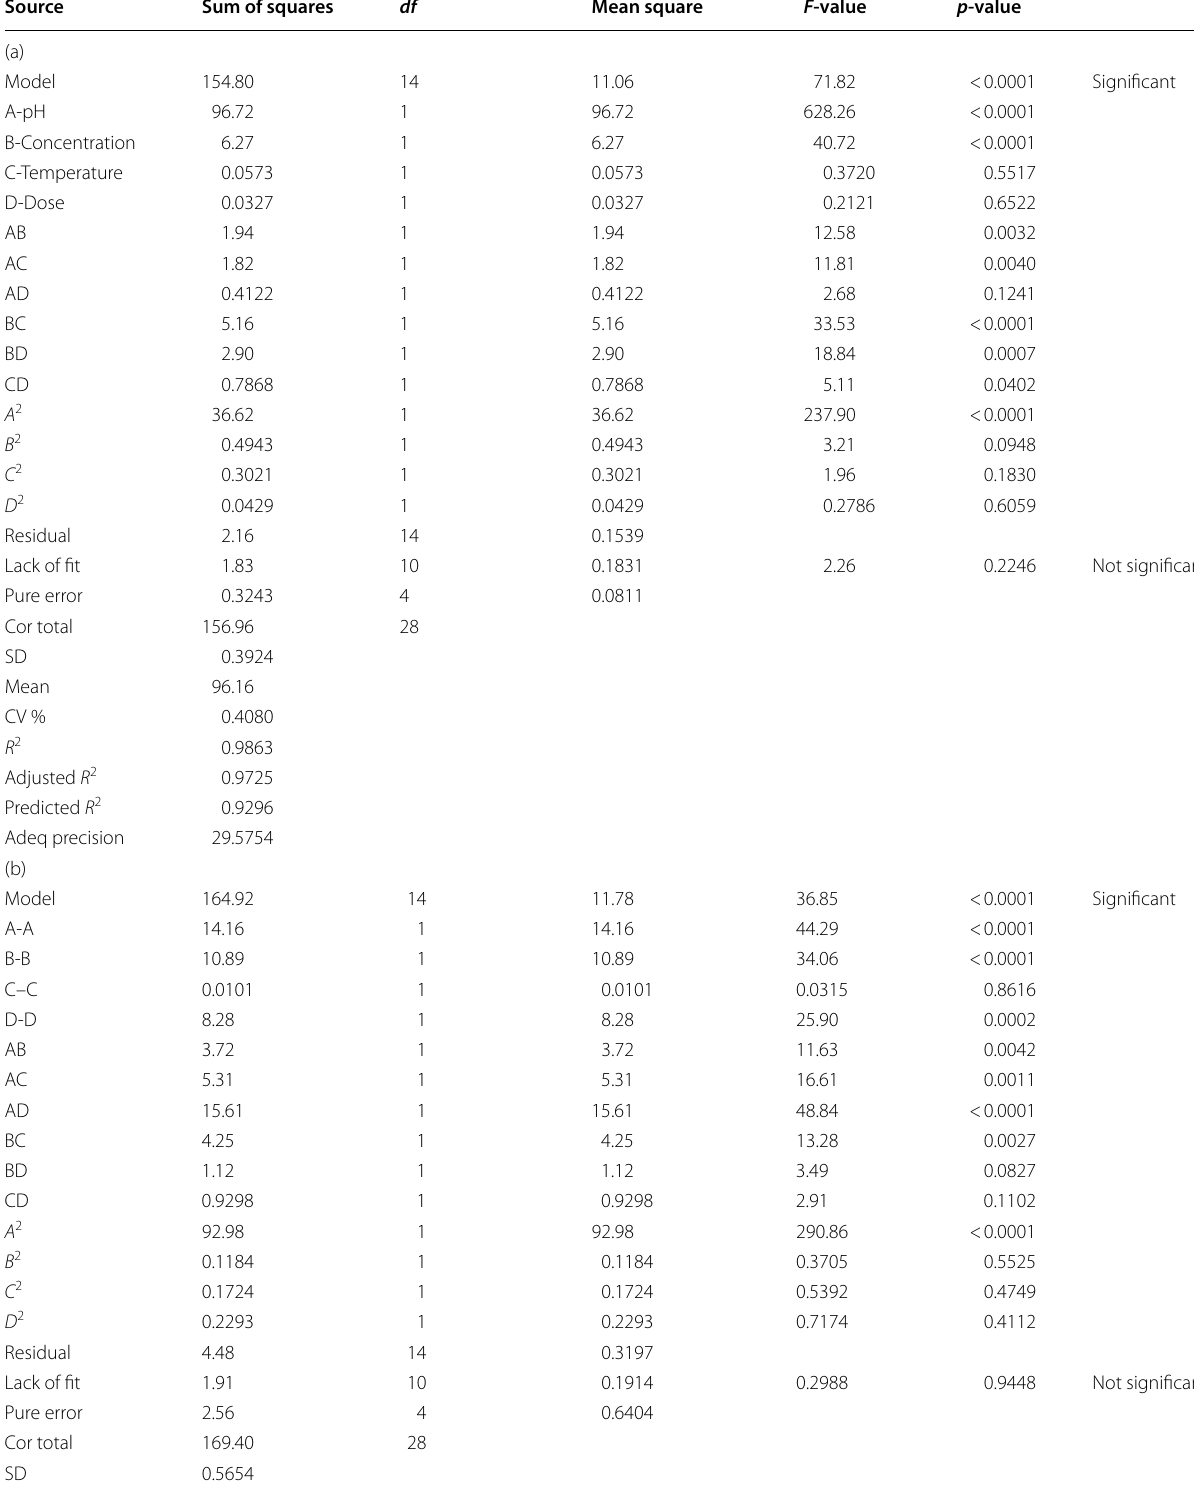
Table 4 Analysis of variance (ANOVA), results for decolourization of MG by (a) nano-bentonite, (b) MgO impregnated clay Source